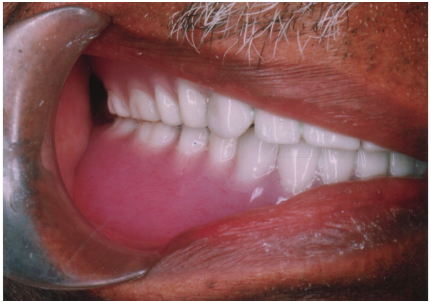
Figure 3: Primary impression in impression compound.